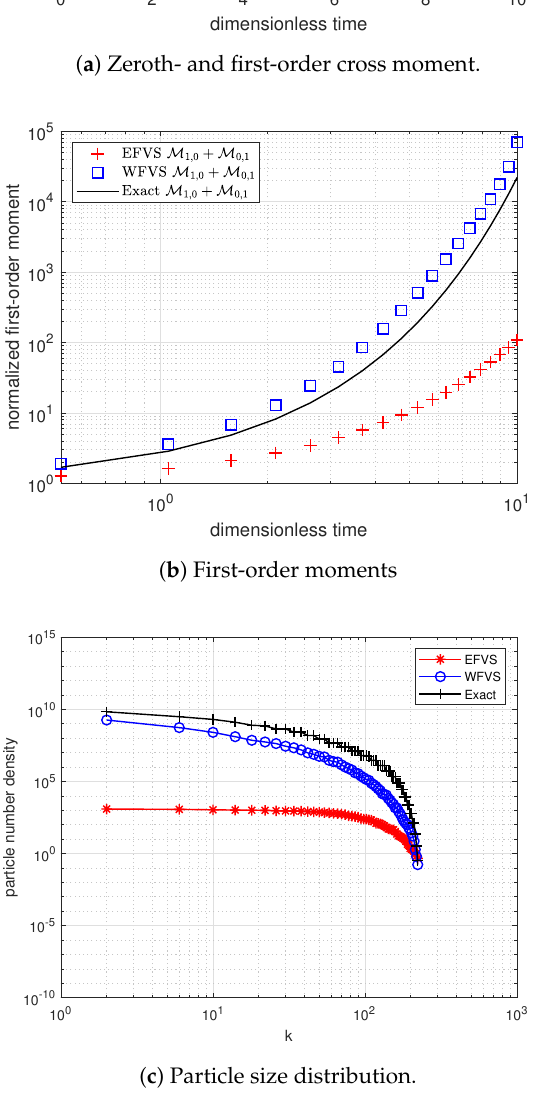
Figure 4. Comparison of different moments with selection function S = 1, and breakage function b 3